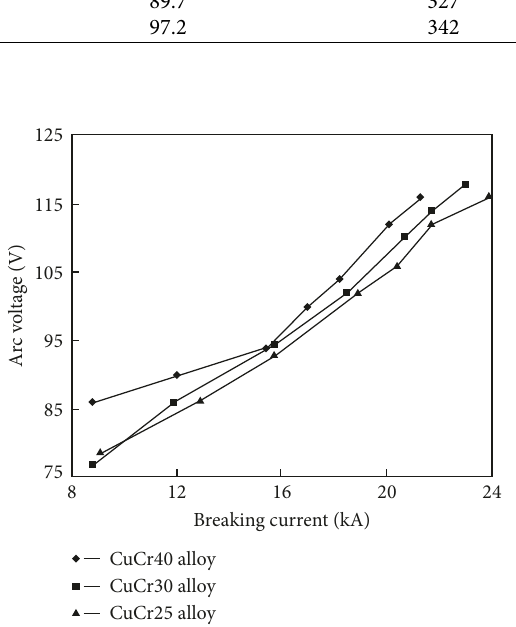
Figure 12: Breaking current and arc voltage at current peak